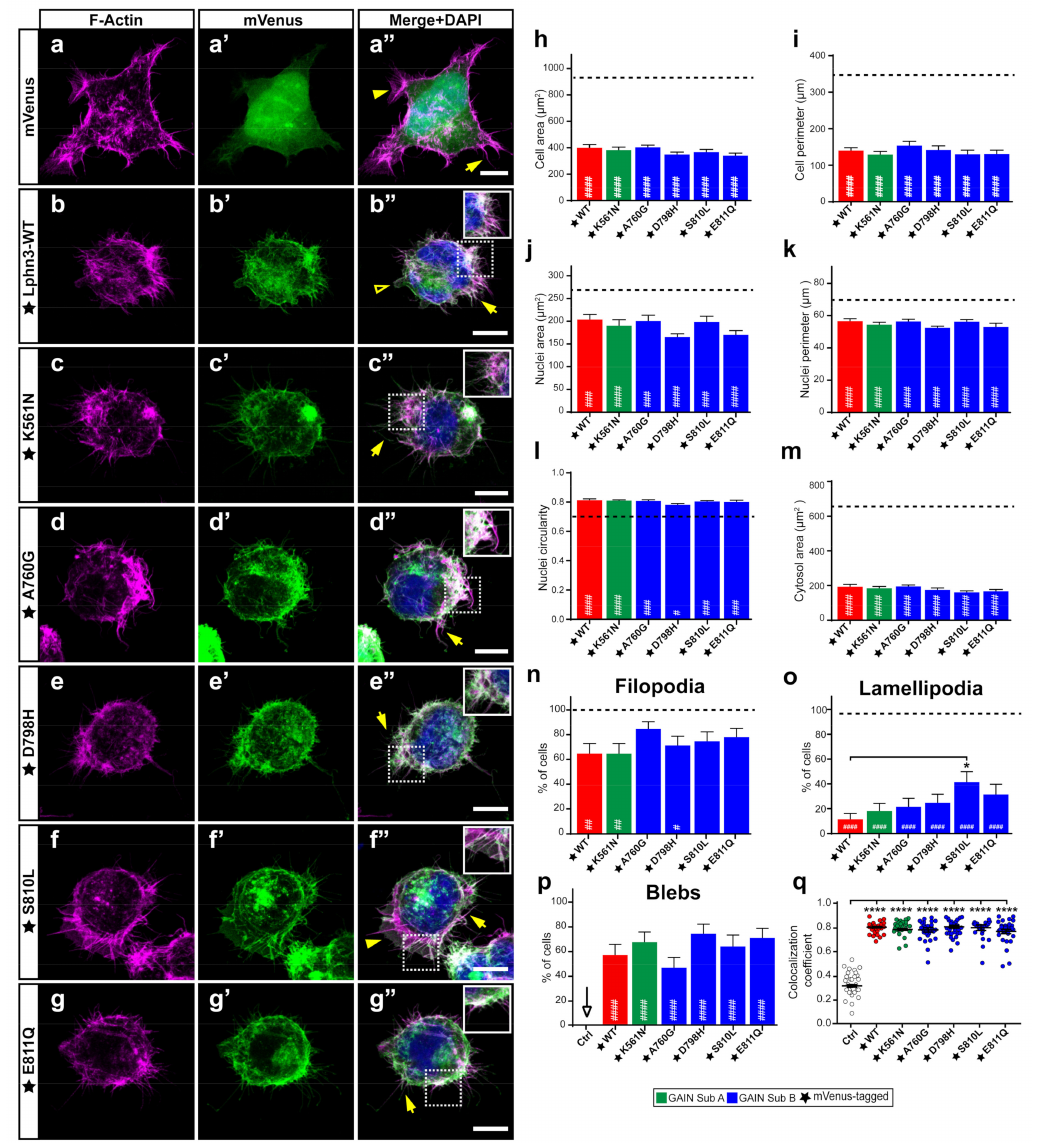
Figure 5. Lphn3-mediated actin remodeling is altered by the presence of S810L mutation. Rep- resentative confocal fluorescence microscopy images of HEK293 cells expressing ( a’ – g’ ) mVenus (Ctrl) or the indicated mVenus-tagged Lphn3 variants (green), for which ( a – g ) F-actin was stained with phalloidin rhodamine (magenta) and ( a” – g” ) DAPI for nuclei (blue) in corresponding merged images. Inset images show colocalization of F-actin with the receptor represented as white pixels. Actin-dependent extensions are indicated as follows: filopodia (arrow), lamellipodia (arrowhead) and blebs (empty arrowhead). Scale bar: 10 µ m. ( h – m ) Quantification of the different cellular and nuclear dimensions. ( n – p ) Quantitation of actin-dependent extensions present in transfected cells. Dotted line represents values obtained for mVenus-expressing cells used as control. ( q ) Pearson’s coefficient scatter plot representing coincident pixels between F-actin rhodamine signal and fluorescence emitted by mVenus-tagged Lphn3 variants. Subdomain A (GAIN Sub A) and B (GAIN Sub B) of GAIN domain. mVenus-tagged receptor constructs are indicated by a star ( (cid:70) ). Data are represented as the mean values of at least three independent experiments ( n = 3). At least 30 cells were analyzed for each condition. Statistical analysis was performed using one-way ANOVA. Error bars indicate S.E.M., p values between mVenus-tagged Lphn3-variants and control data are indicated by # inside histograms, while p values between mVenus-tagged Lphn3-variants and Lphn3-WT are indicated by *: #### or **** p ≤ 0.0001, ### p ≤ 0.001, ## p ≤ 0.01, # or * p ≤